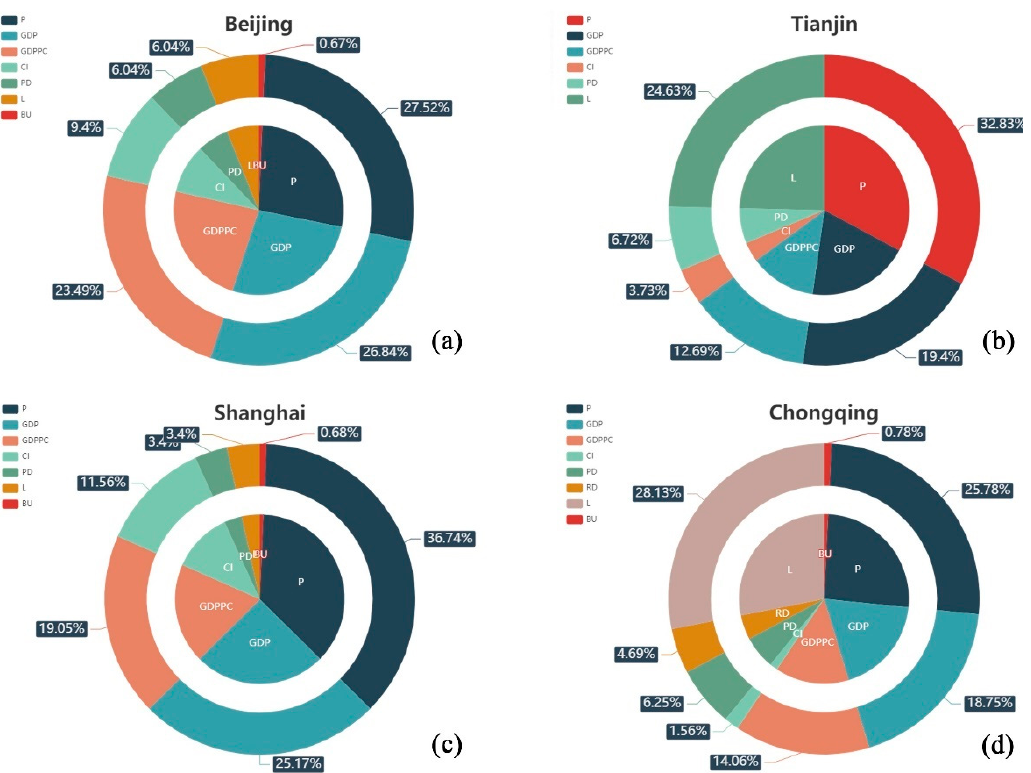
Figure 4. CE and influence factors regression results using XGBoost. ( a ) Beijing; ( b ) Tianjin; ( c ) Shanghai; ( d ) Chongqing.